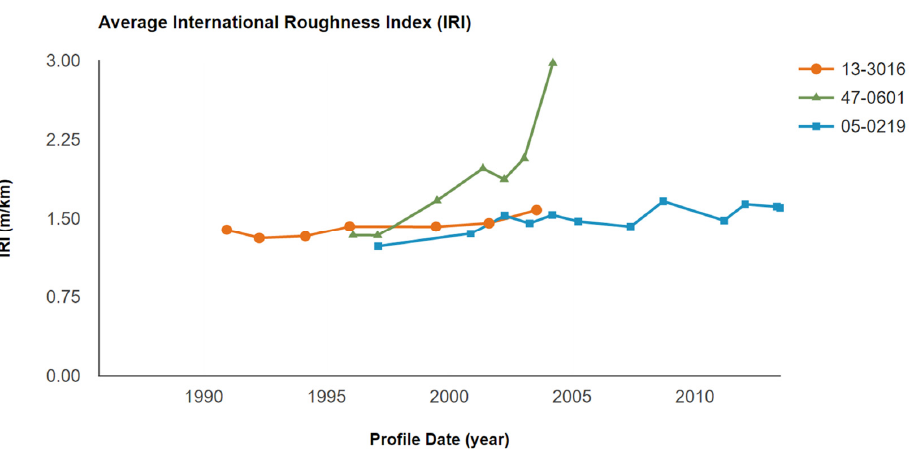
Figure 7. The comparison of the IRI with different joint spacings. Table 3. FHWA IRI Categories.